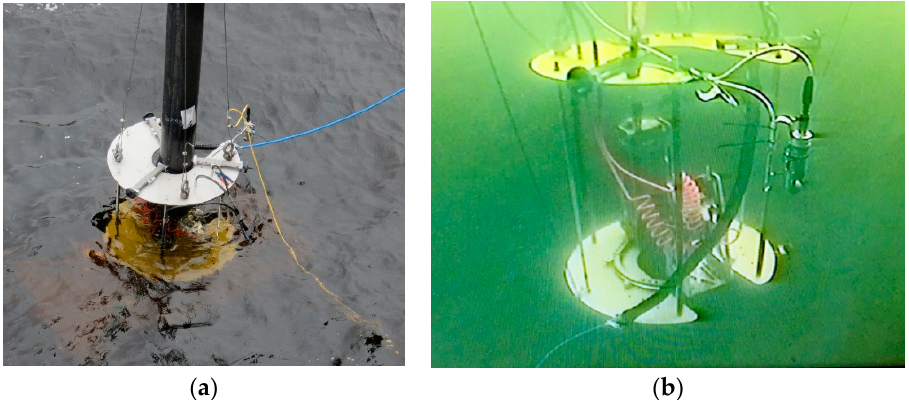
Figure 7. ( a ) Robotic system being submerged around the riser; ( b ) system in operation underwater.